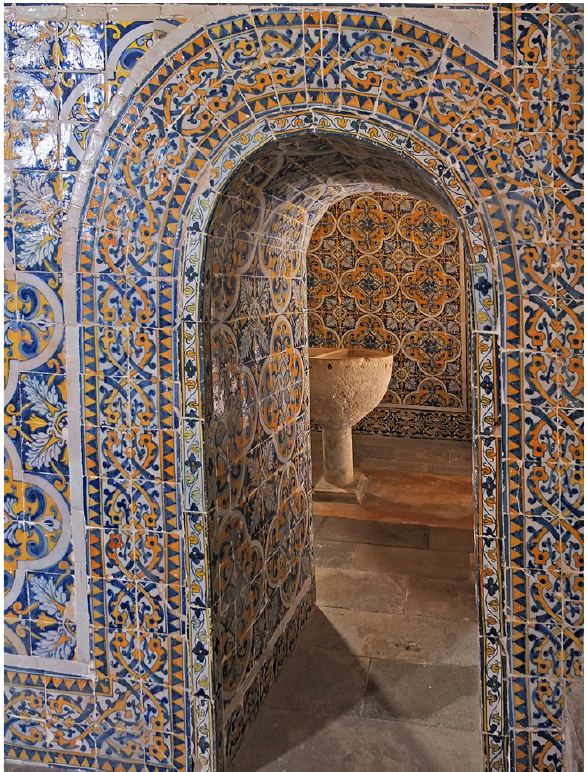
Figure 4. Almoster, Church of the Convent of Almoster,